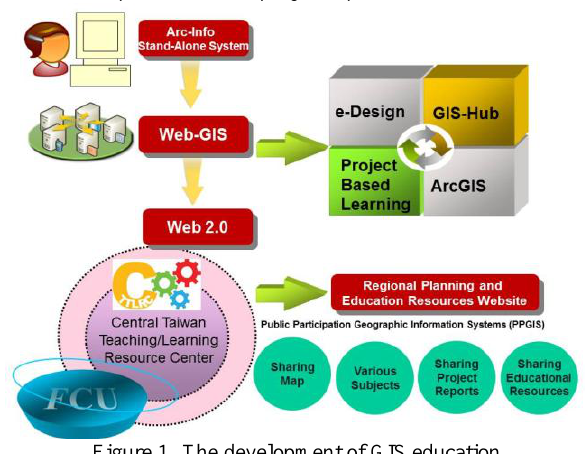
Figure 1 The development of GIS education